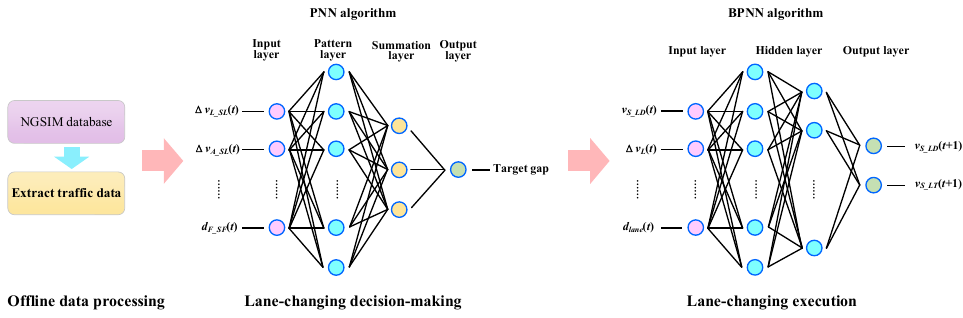
Figure 2. Pipeline illustration of a joint neural network model.